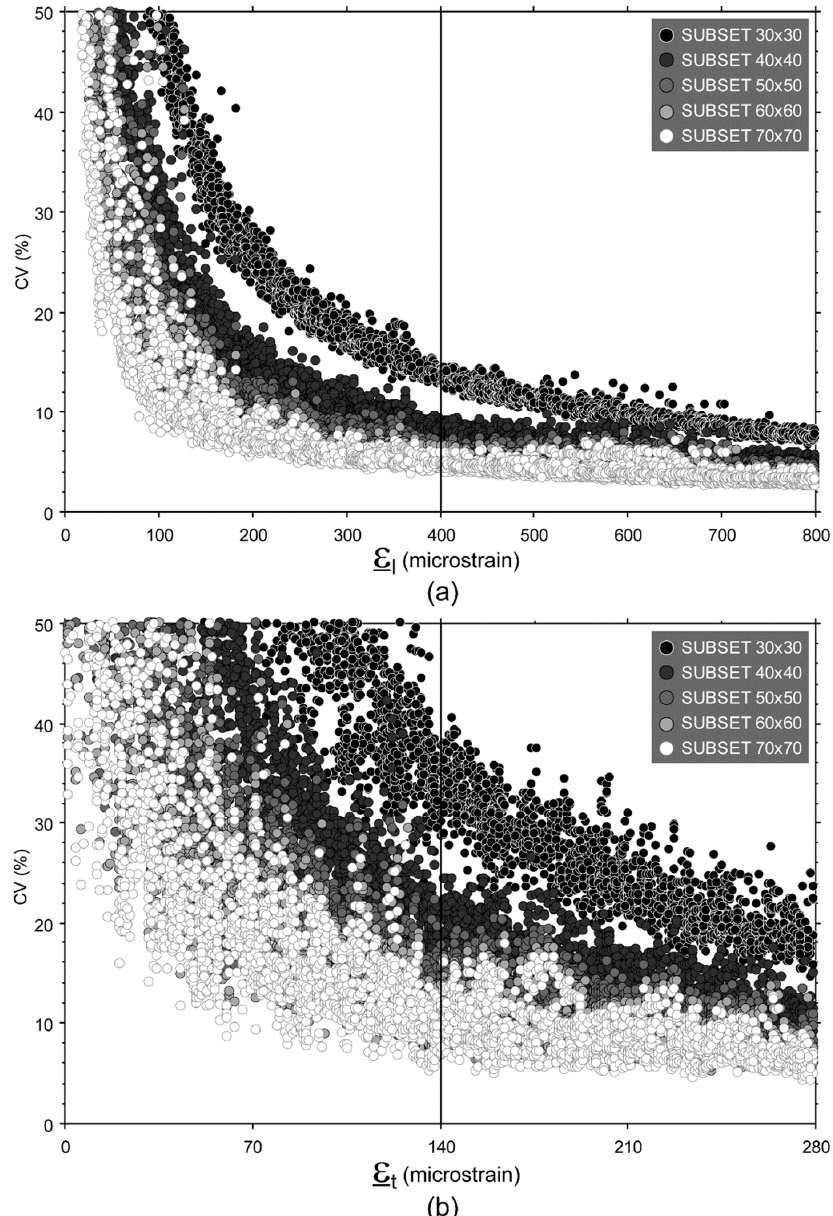
Figure 3. Representation of CV values calculated on the same image datasets changing the subset size from 30 × 30 to 70 × 70 pixels. ( a ) ε l values; ( b ) ε t values. Note: Each circle represents the CV of all strain values ( ε ) measured on the area of interest of a couple of images simultaneously acquired on both sides of the specimen.